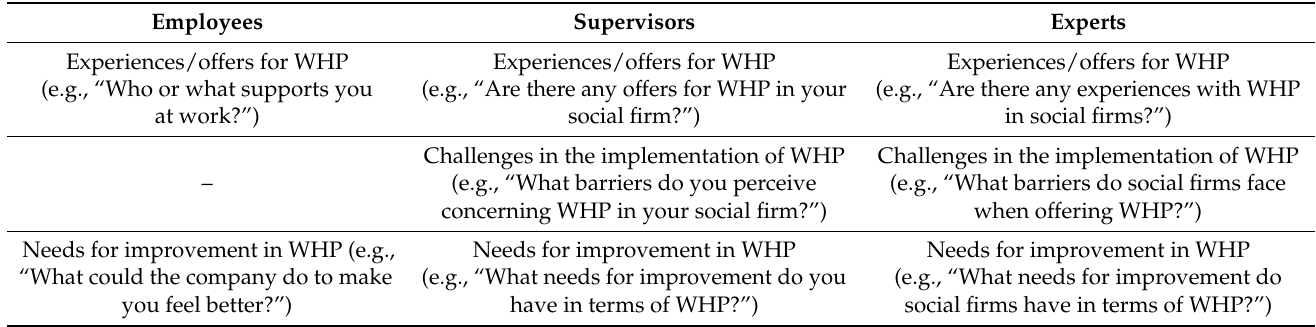
Table 3. Topics of the interview guideline for employees, supervisors and